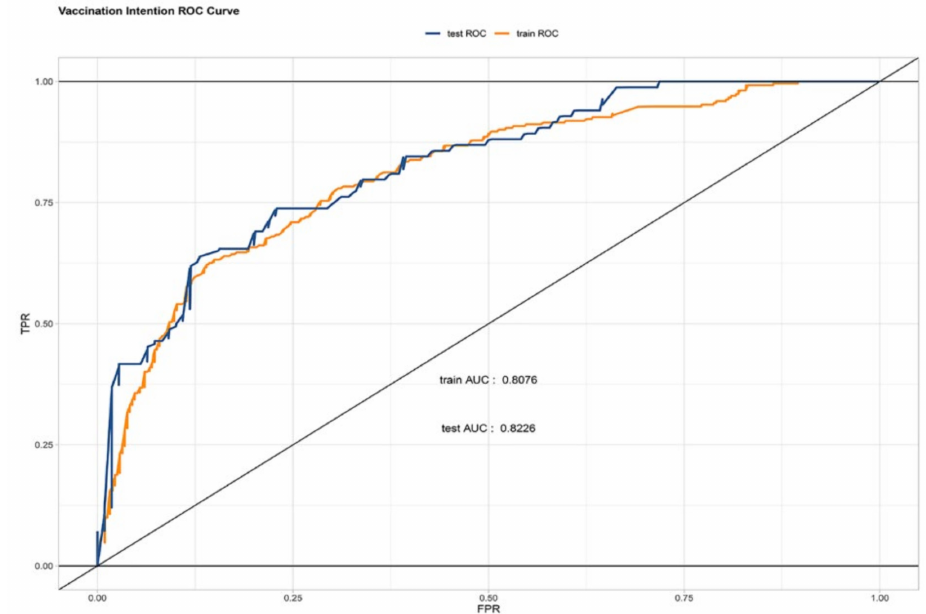
Figure 3. The pooled AUC of the ROC curve in the training set and test set. Receiver operating characteristic curve (ROC) validation of the vaccination intention nomogram prediction. The y -axis represents the true positive rate of the prediction, and the x -axis represents the false positive rate of the prediction. The orange line represents the performance of the model in the training set, and the blue line represents the performance of the model in the test